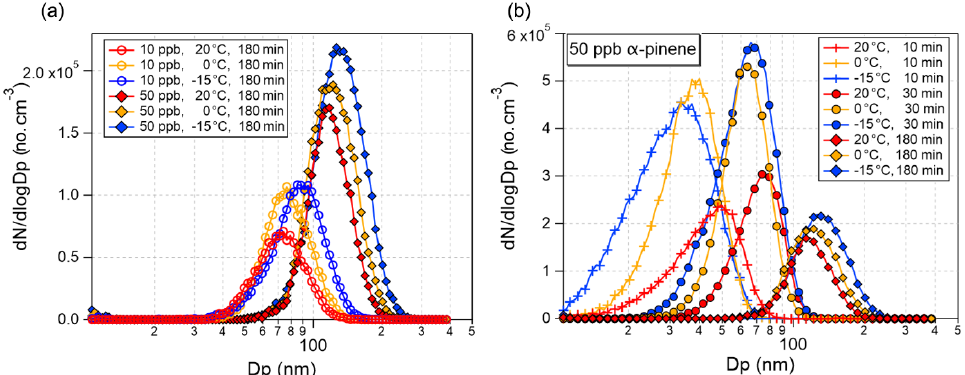
Figure 3. (a) Particle size distribution recorded 180min after the ozone-initiated oxidation of 10 (Exp. 1.1–1.3) and 50ppb (Exp. 2.1–2.3) α -pinene at 20 ◦ C (red), 0 ◦ C (orange), and − 15 ◦ C (blue). (b) Particle size distribution recorded 10, 30, and 180min after injection of 50ppb α -pinene at 20 ◦ C (Exp. 2.1, red), 0 ◦ C (Exp. 2.2, orange), and − 15 ◦ C (Exp. 2.3, blue).